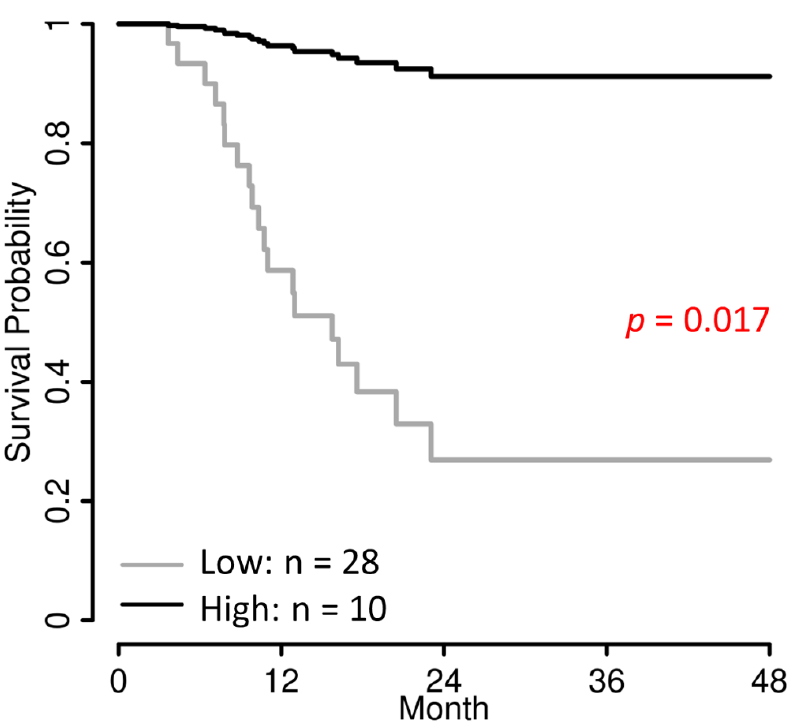
Figure 4. Kaplan – Meier estimates for PFS categorizing cVAF optimally in a low and high cVAF group. Shading areas are 95% confidence intervals.